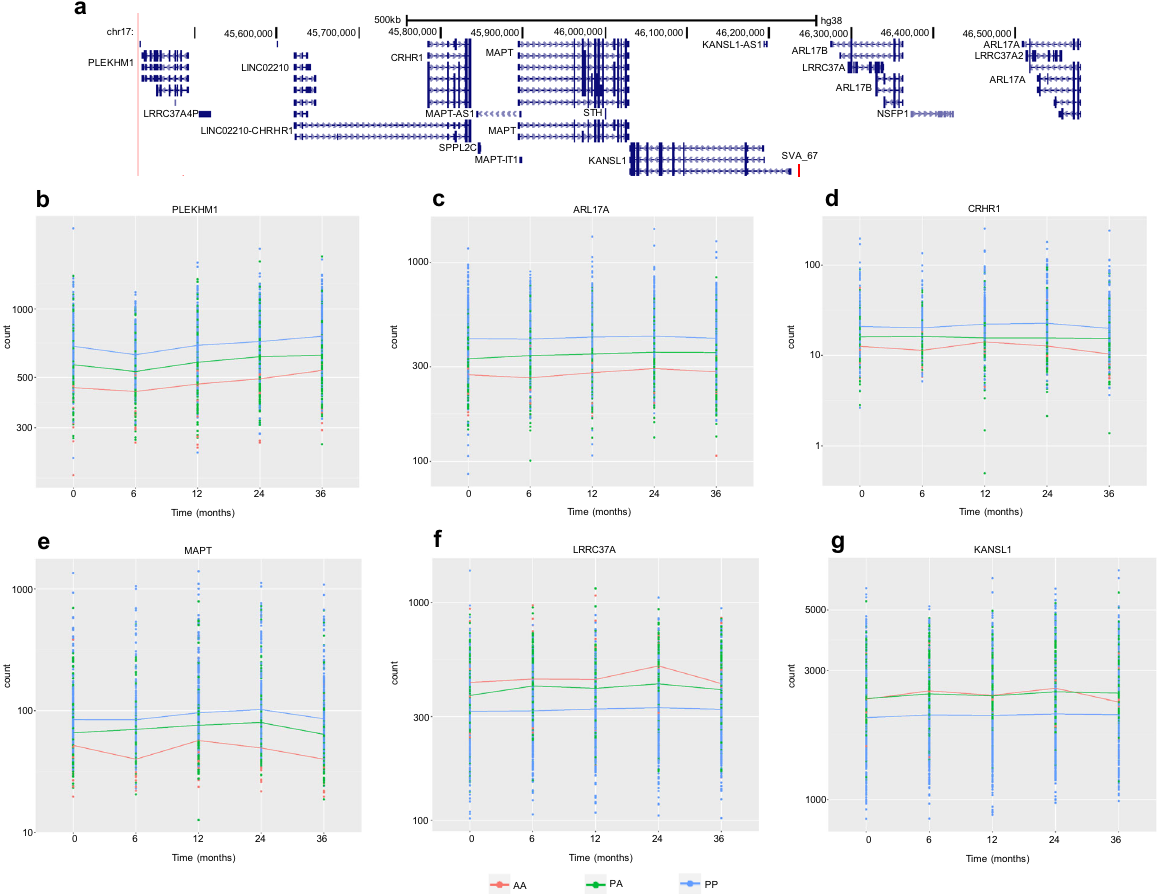
Fig. 4 The expression of several genes at the 17q21.31 locus were associated with SVA_67. a A schematic modi fi ed from UCSC genome browser of the 1.15 Mb region on chromosome 17 that contains six of the genes whose expression was associated with SVA_67. b At 0 months a 1.5 fold change in expression of PLEKHM1 was signi fi cantly associated with SVA_67 genotype when comparing PP to AA (FDR p = 2.38 × 10 − 6 ) and a 0.8 fold change in expression when comparing PA to PP (FDR p = 2.40 × 10 − 9 ). At 36 months a 1.4 fold change in expression of PLEKHM1 was signi fi cantly associated with SVA_67 genotype when comparing PP to AA (FDR p = 0.008) and a 0.8 fold change in expression when comparing PA to PP (FDR p = 1.01 × 10 − 6 ). c At 0 months a 1.6 fold change in expression of ARL17A was signi fi cantly associated with SVA_67 genotype when comparing PP to AA (FDR p = 8.72 × 10 − 5 ) and a 0.8 fold change in expression when comparing PA to PP (FDR p = 1.21 × 10 − 9 ). At 36 months a 1.5 fold change in expression of ARL17A was signi fi cantly associated with SVA_67 genotype when comparing PP to AA (FDR p = 0.006) and a 0.8 fold change in expression when comparing PA to PP (FDR p = 0.003). d At 0 months a 1.8 fold change in expression of CRHR1 was signi fi cantly associated with SVA_67 genotype when comparing PP to AA (FDR p = 7×10 − 4 ) and a 0.7 fold change in expression when comparing PA to PP (FDR p = 1.47 × 10 − 8 ). At 36 months a 2.1 fold change in expression of CRHR1 was signi fi cantly associated with SVA_67 genotype when comparing PP to AA (FDR p = 2.5 × 10 − 4 ) and a 0.7 fold change in expression when comparing PA to PP (FDR p = 1.87 × 10 − 5 ). e At 0 months a 0.8 fold change in expression of MAPT was signi fi cantly associated with SVA_67 genotype when comparing PA to PP (FDR p = 0.001). At 36 months a 2.3 fold change in expression of MAPT was signi fi cantly associated with SVA_67 genotype when comparing PP to AA (FDR p = 0.002) and a 0.7 fold change in expression when comparing PA to PP (FDR p = 0.01). f At 0 months a 1.2 fold change in expression of LRRC37A was signi fi cantly associated with SVA_67 genotype when comparing PA to PP (FDR p = 0.03). At 36 months 1.2 fold change in expression of LRRC37A was signi fi cantly associated with SVA_67 genotype when comparing PA to PP (FDR p = 0.002). g At 36 months 1.2 fold change in expression of KANSL1 was signi fi cantly associated with SVA_67 genotype when comparing PA to